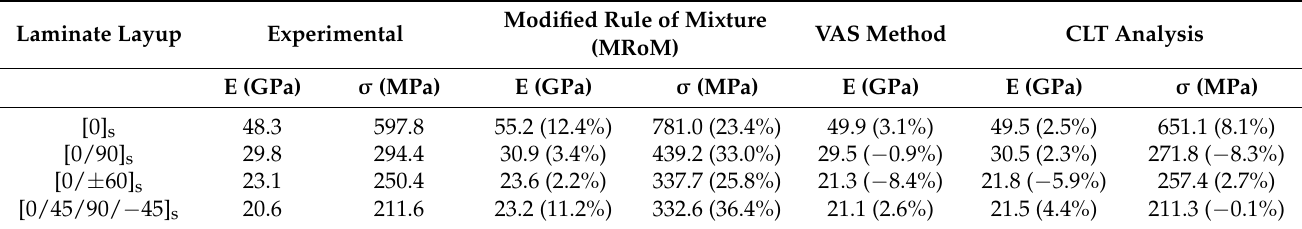
Table 8. Comparison between the elastic modulus and tensile strength of CCF/PA composites obtained experimentally and predicted using MRoM, VAS method and CLT analysis. The relative error (%) is reported in